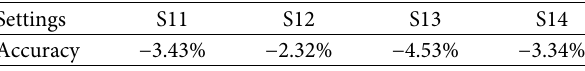
)/increment (+) of different −